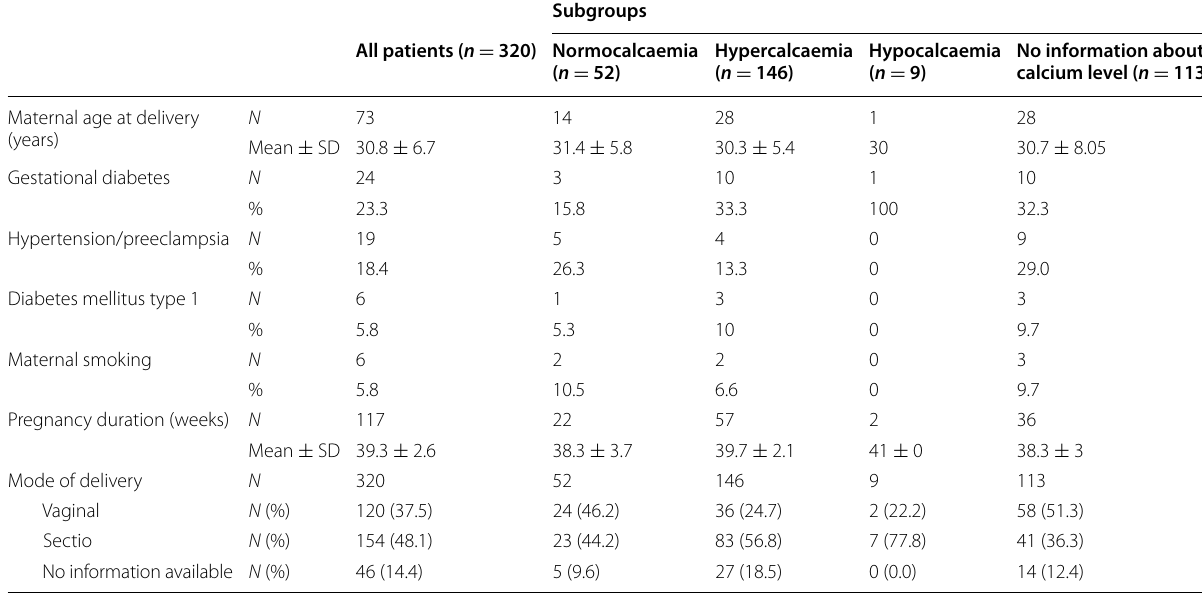
Table 3 Maternal characteristics that are potentially related to the development of SCFN in their